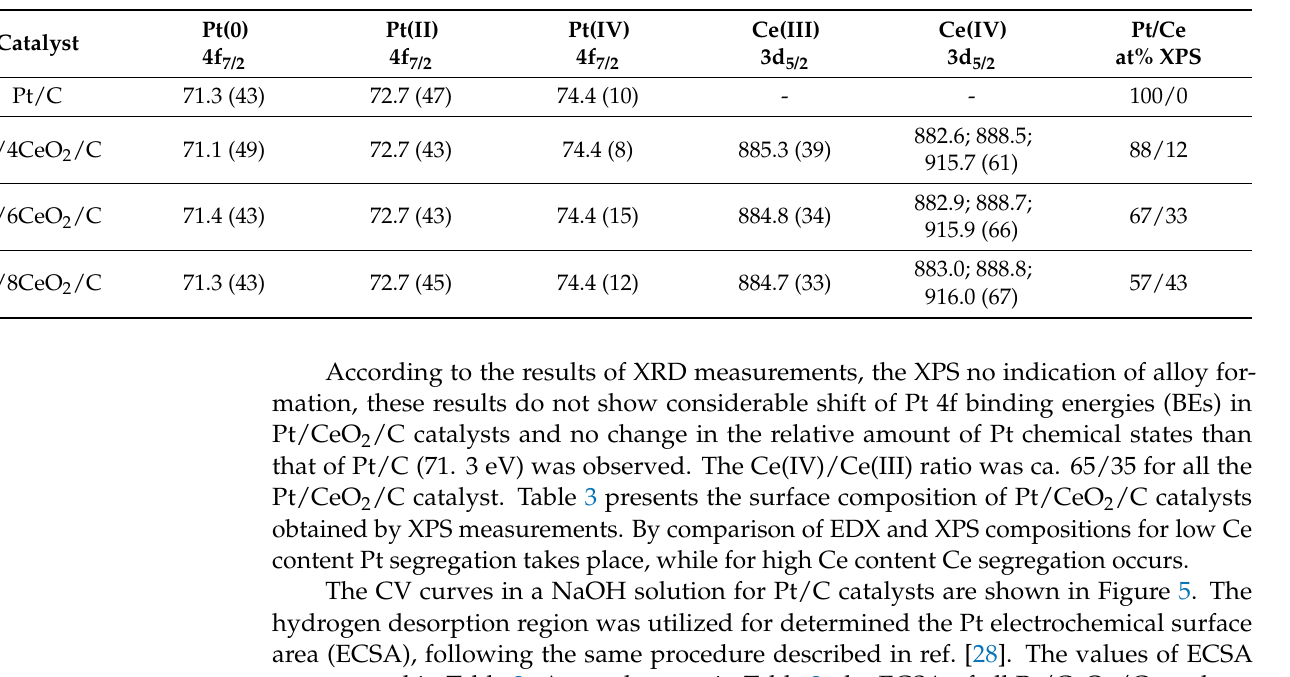
Figure 4. High-resolution XPS scan of Pt 4f and Ce 3d of Pt/C and Pt/CeO 2 /C catalysts. Table 3. Binding energy values of Pt/CeO 2 /C and Pt/C catalysts, with the relative % of different oxidation states indicated in parenthesis and the XPS atomic